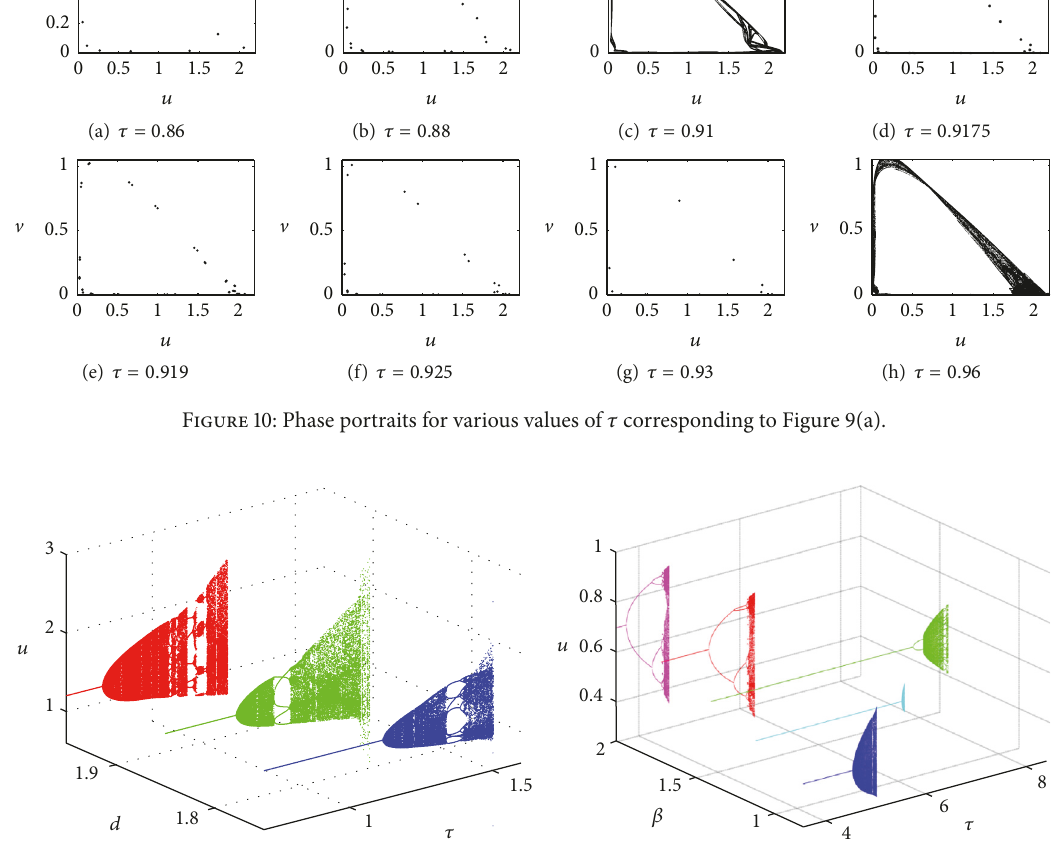
fixed point (0.5727, 0.4496) is a stable attractor at 𝜏 = 0.55